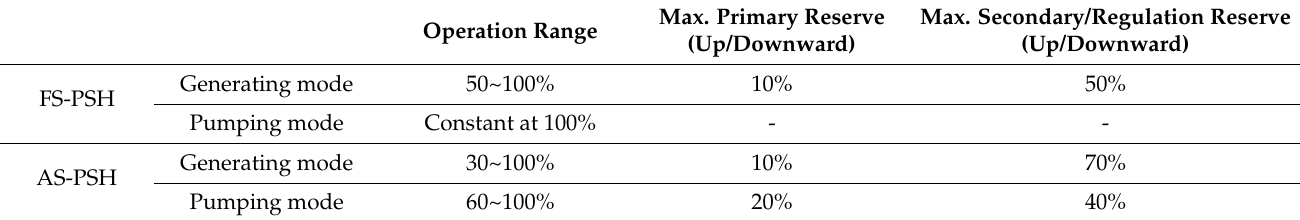
Figure 7. Operation and reserve ranges of PSH (pumping mode). Table 5. Operation and reserve range of FS-PSH and